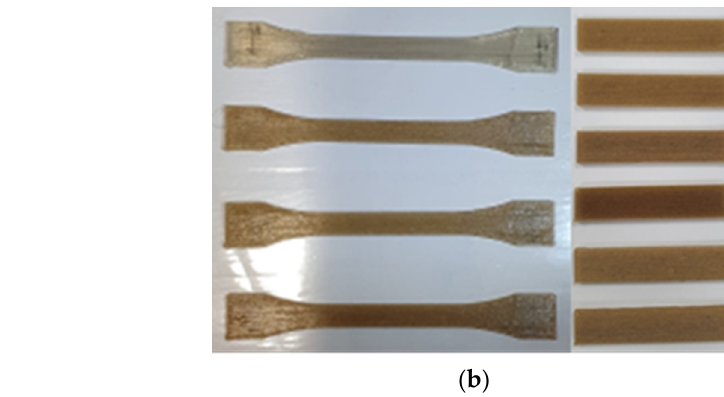
Figure 4. Tensile and flexural specimens: ( a ) schematic of the specimens with dimensions in millimeters (the specimen thickness is shown in gray) and ( b ) photos of the 3D printed specimens.